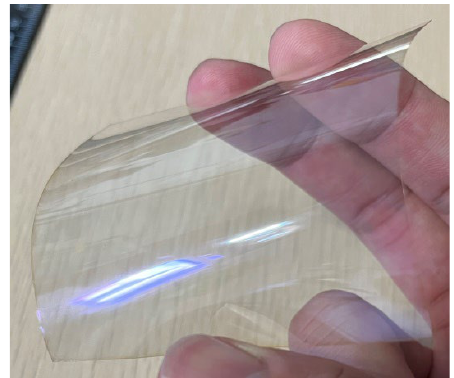
Figure 5. Transparent nafion polymer electrolyte membrane.